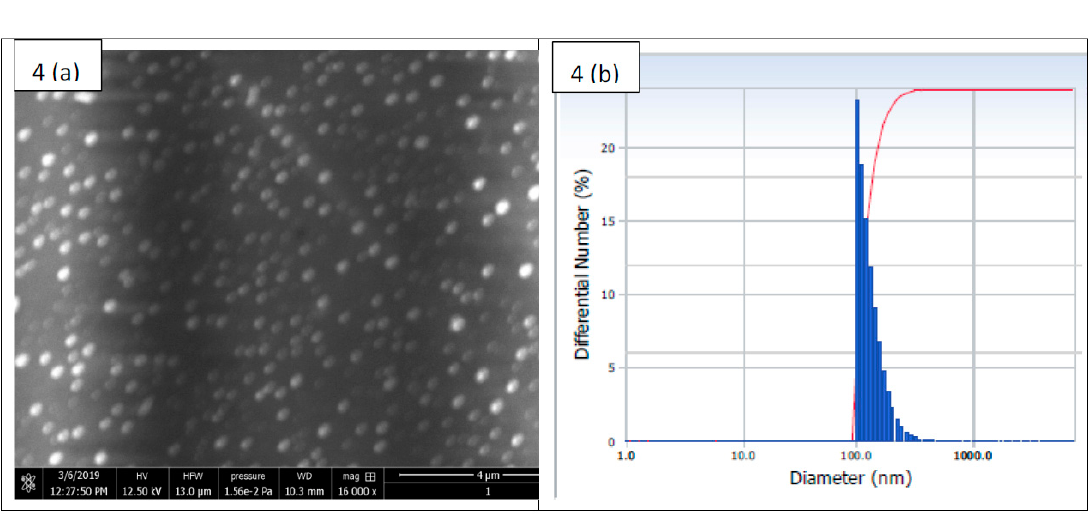
Figure 4. Size distribution of Eudragit RL-100 encapsulated gentamicin sulfate (E-G-S) nanoparticles. ( a ) SEM image; ( b ) Dynamic light scattering (DLS) measurement of particle size distribution.